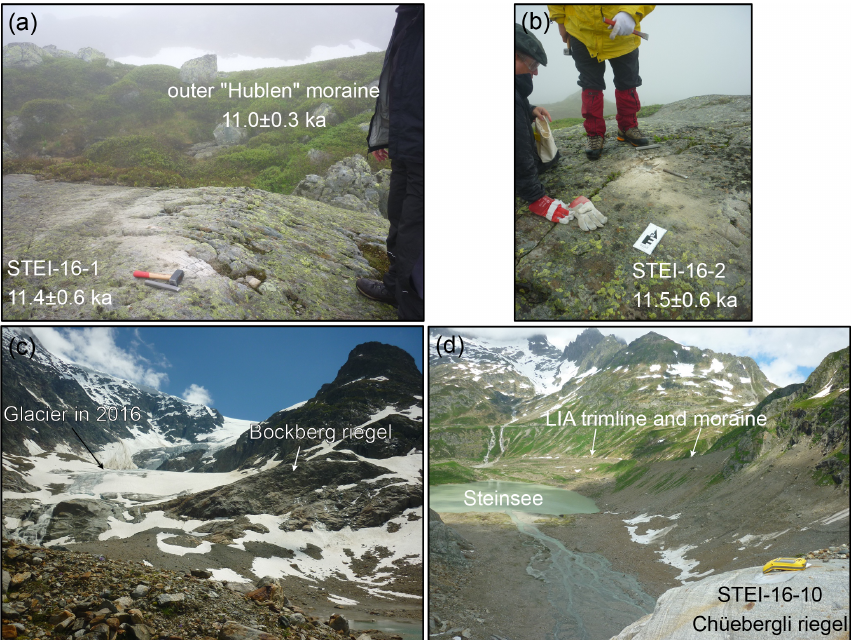
Figure 2. Photographs taken during field work. (a, b) Bedrock surfaces sampled close to the summit of Hublen Plateau. (c) Bockberg riegel and the glacier terminus in the year 2016. (d) Location of sample STEI-16-10 on Chüebergli riegel with the view on the eastern side of the Steingletscher forefield, highlighting the LIA trimline and composite